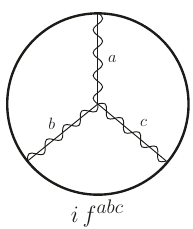
Figure 9 . The vertex correction to